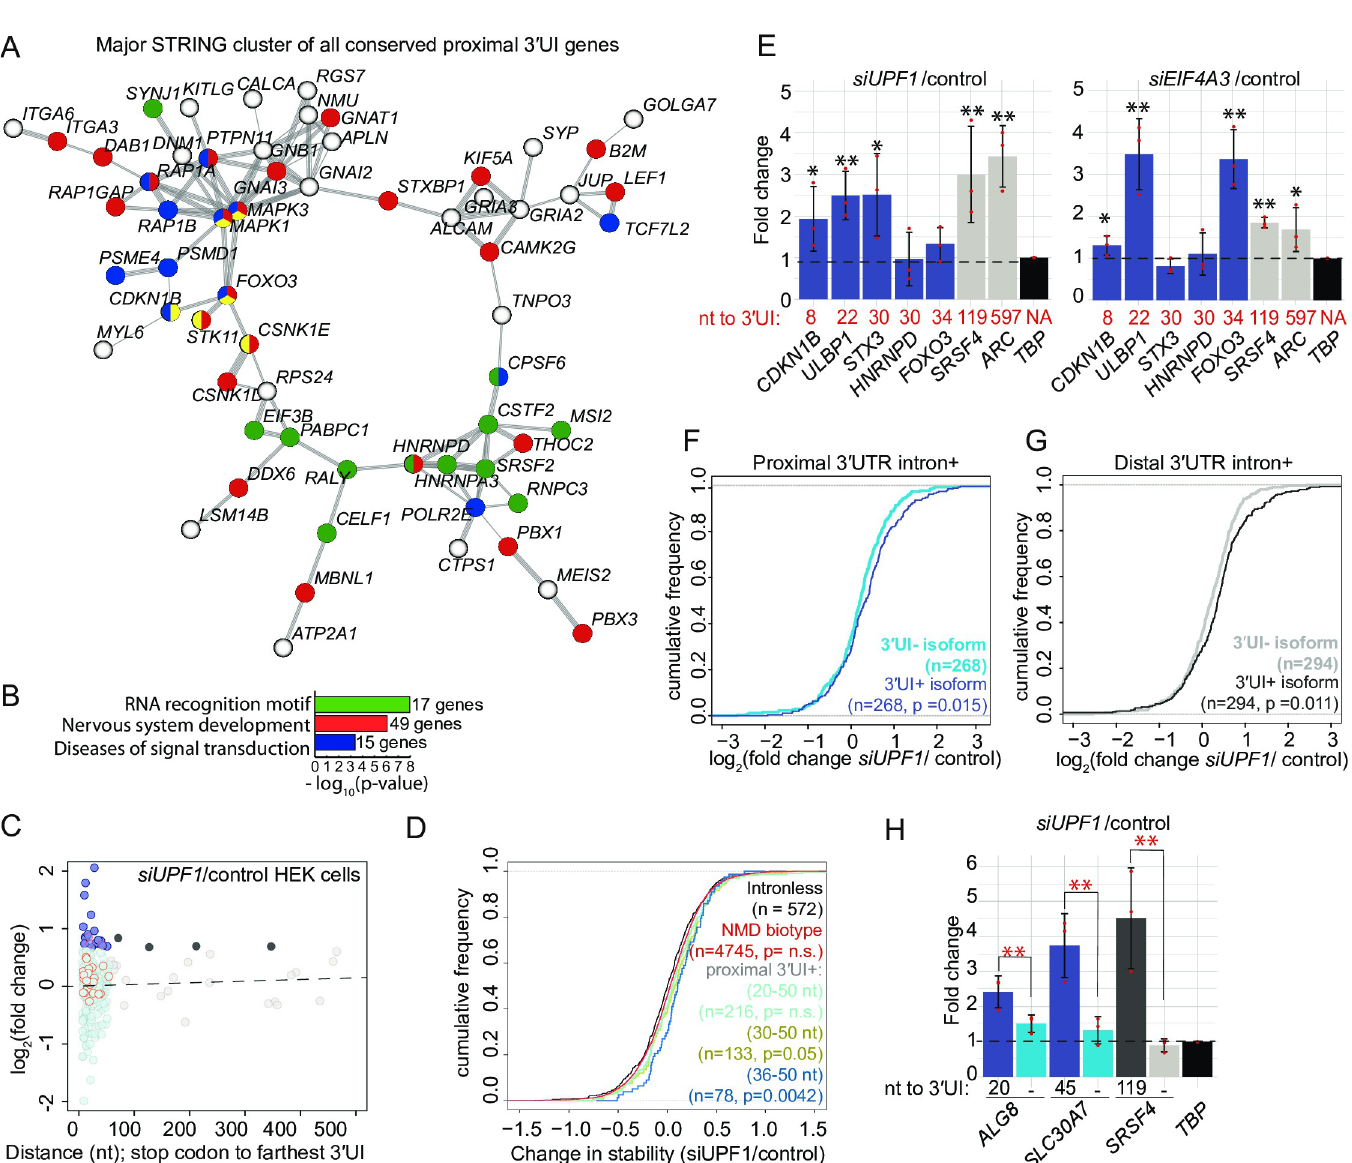
Fig 7. Proximal position of 3 0 UTR introns is conserved in many vertebrate genes and a subset of proximal 3 0 UI-containing genes are NMD-sensitive in human cells. A. A major interaction cluster predicted by STRING network analysis of genes with a 3 0 UI in proximal position in zebrafish, mouse and human. Nodes are colored by gene/protein function: nervous system (red), presence of RNA recognition motif (RRM) (green), diseases of signal transduction (blue), FoxO signaling pathway (yellow). (167 nodes and 127 edges in total, PPI enrichment p-value = 0.02). B. Gene ontology enrichment analysis of all 167 genes with conserved 3 0 UI proximal positioning. The most significant GO term within the following functional categories are shown: Interpro domains, Biological process and Reactome pathways. C. A scatter plot showing fold changes for APPRIS-annotated proximal 3 0 UI transcripts (dark blue: FC > 1.5 and light blue: FC < 1.5) and distal 3 0 UI transcripts (black: FC > 1.5 and gray: FC < 1.5) in UPF1 knockdown HEK293 cells compared to control cells [57]. Dots encircled in red are transcripts that also contain an uORF as determined previously in [57]. Same analysis for Ensembl transcript annotations is shown in Fig S5G. D. Empirical CDF plot showing change in mRNA stability for different classes of NMD targets and intron-less genes upon UPF1 knockdown in HEK293 cells (data from [57]). The gene classes are as follows: proximal 3 0 UI-containing genes where distance is 20–50 nts (light green), 30–50 nts (olive green) and 36–50 nts (dark blue), Ensembl-annotated NMD-biotype genes (red) and intron-less genes (black). CDF function is plotted as in Fig 5B. KS test p-value for comparison of NMD targets to intron-less genes is indicated in the same color. E. qRT-PCR analysis showing fold changes for proximal 3 0 UI-containing genes CDKN1B , FOXO3 (upregulated in zebrafish); ULBP1 ; STX3 (highest change in stability upon UPF1 KD in HEK293 cells [57]); HNRNPD (encodes RRM-containing protein) and distal 3 0 UI-containing genes ( ARC and SRSF4 ) upon UPF1 (left) and EIF4A3 (right) knockdown in HCT116 cells. The distance between stop codon and 3 0 UI for every 3 0 UI-containing gene is indicated below each bar. TBP is the normalizing gene used for qRT-PCR analysis. Welch’s t-test p-values are indicated using asterisks ( �� p-value < 0.05 and � p-value < 0.1). F. Empirical CDF plot of fold changes in levels of 3 0 UI-containing isoforms (dark blue) as compared to 3 0 UI-lacking isoforms (sky blue) encoded from same genes in UPF1- depleted HEK293 cells. KS test p-value for differences in the two distributions is indicated on the bottom right. G. CDF plot as in F showing the fold changes in levels of distal 3 0 UI-containing (black) versus 3 0 UI-lacking isoforms (gray). H. qRT-PCR analysis showing